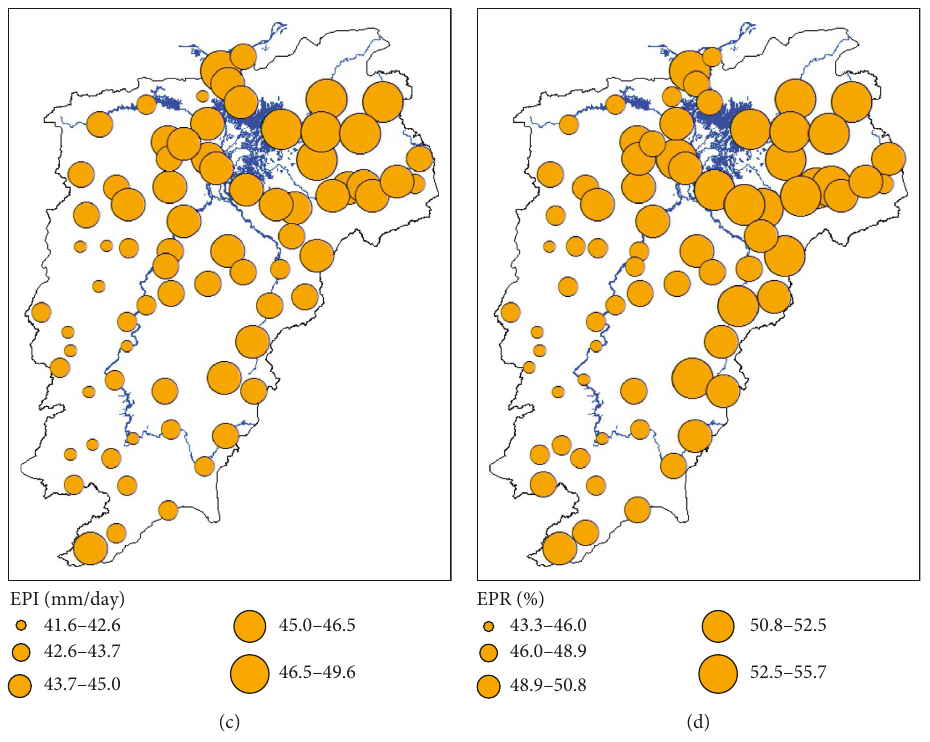
Figure 4: Spatial distributions of (a) EPD, (b) EPA, (c) EPI, and (d) EPR in Poyang Lake basin. Table 4: Regional average of extreme precipitation indices for five